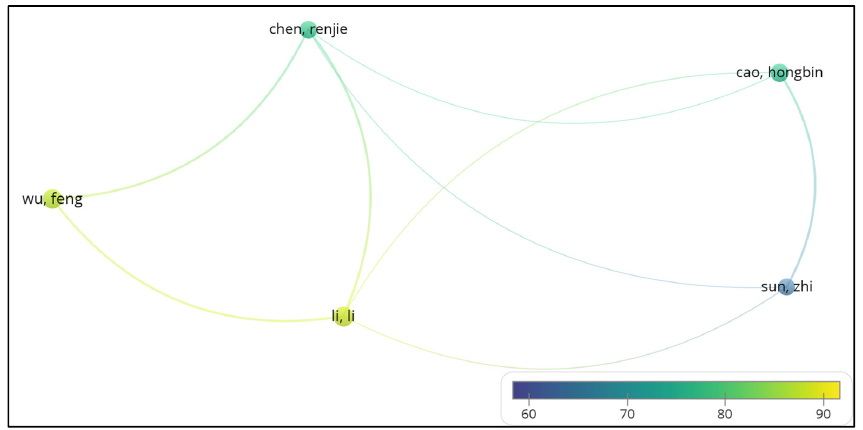
Figure 12. Authors with the greatest number of published articles in the LIB recycling bibliographic portfolio—VOS Viewer Overlay Visualization.